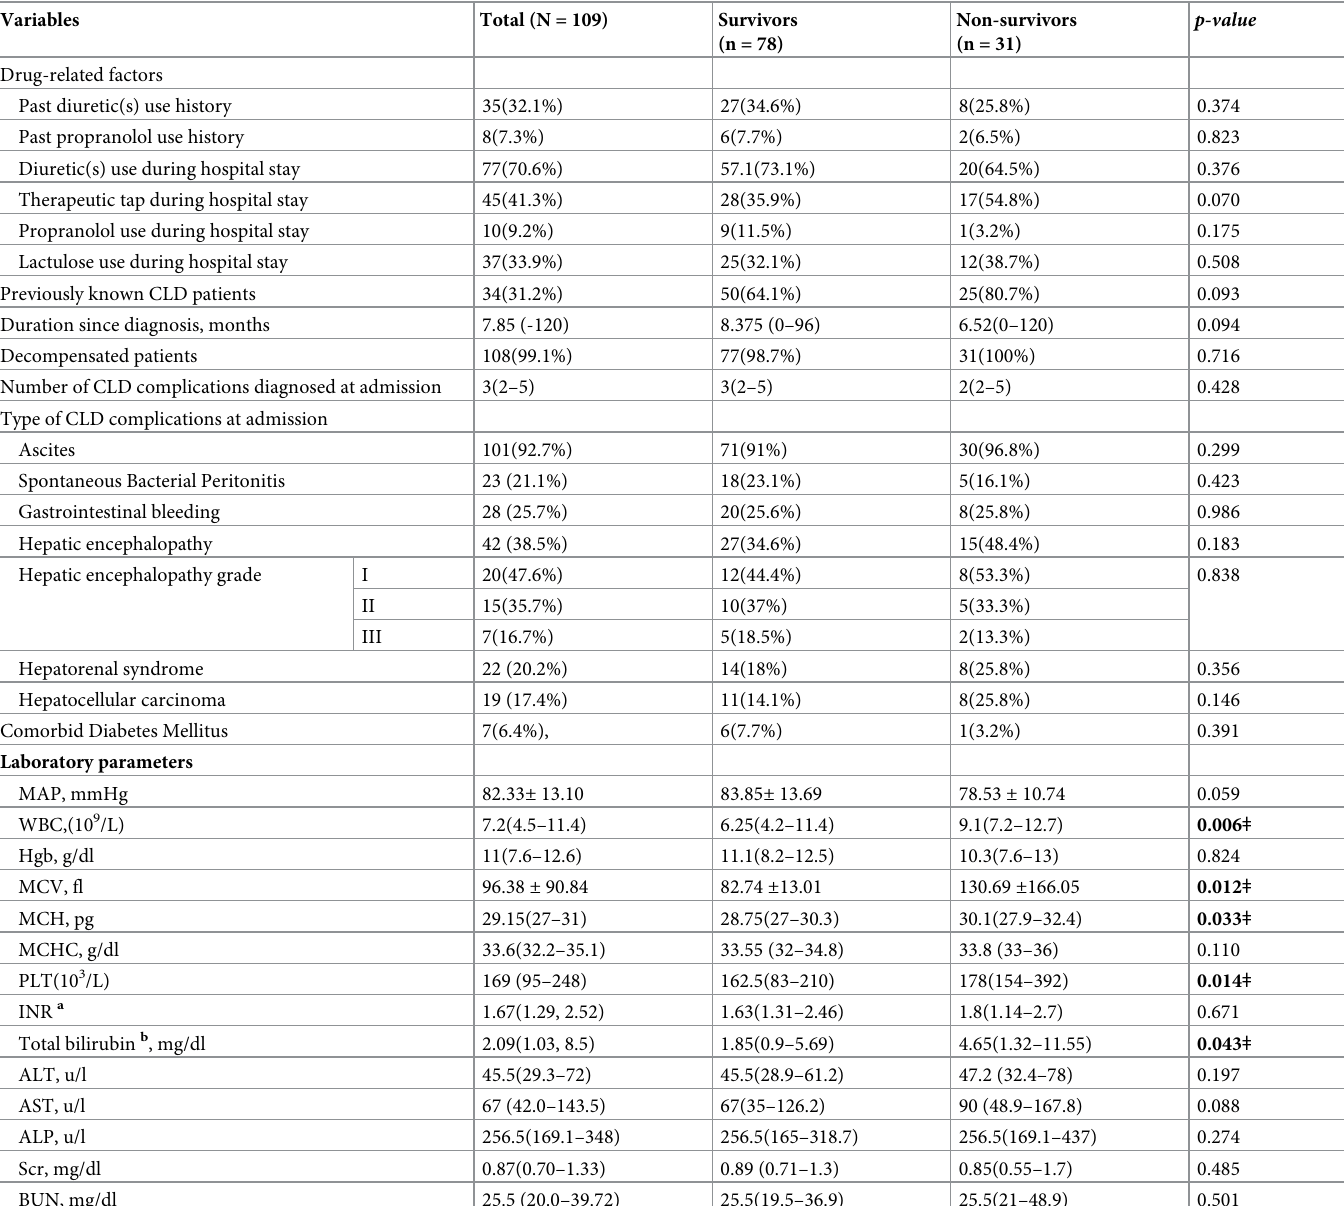
Table 3. Baseline drug-related, clinical and laboratory findings of the study participants in relation to their association with hospital outcome.